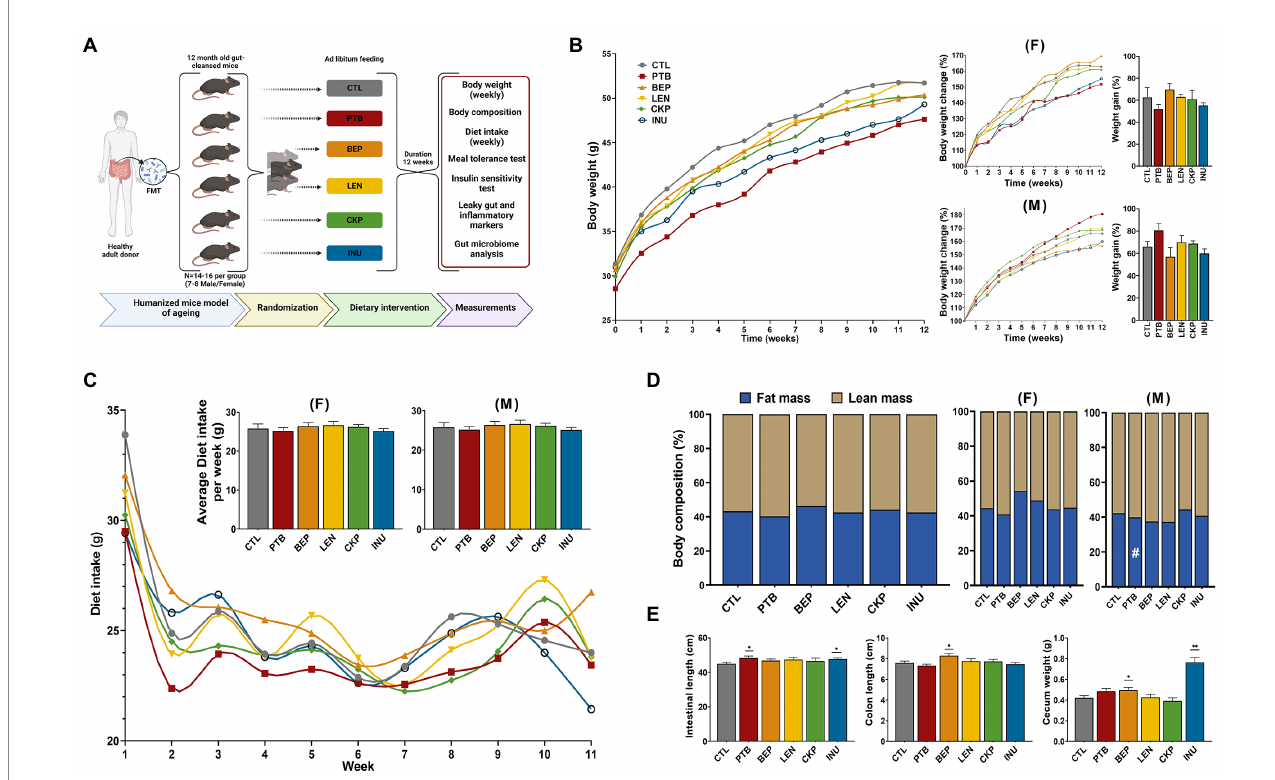
FIGURE 1 Effects of resistant starches from dietary pulses on bodyweight, diet intake, body-composition, total gastrointestinal length, colon length and cecum weight in mice. (A) Experimental Design layout. (B) Overall trend depicting weekly change in bodyweight per group along with sex-specific changes in bodyweight (%) and net weight gain (%). (C) Overall trend depicting weekly diet intake per group along with sex-specific average diet intake per week per group. (D) Overall and sex-specific alterations in body-composition (%) evaluated in terms of total fat and lean mass per group. (E) Comparison of total gastrointestinal length, colon length and cecum weight of prebiotics with control. PTB, Pinto beans; BEP, black-eyed peas; LEN, Lentils; CKP, chickpeas; INU, inulin; CTL, control high-fat diet group. # p < 0.1, * p < 0.05, ** p <